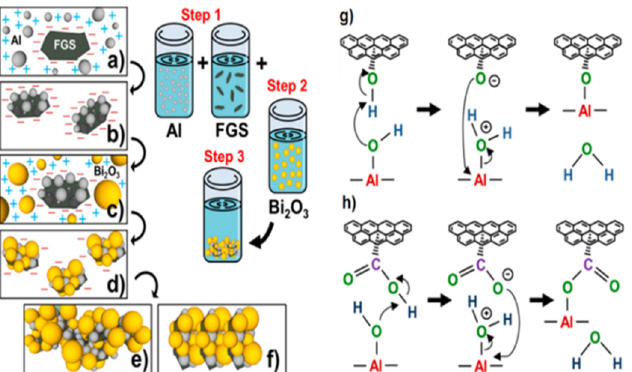
Figure 6. Schematic of the self-assembly process: ( a ) electrostatic attraction of Al to graphene, ( b ) covalent bonding of graphene/Al existing as a stable graphene/Al dispersion, ( c ) electrostatic attraction of Bi 2 O 3 to graphene/Al nanostructures, ( d ) noncovalent assembly of Bi 2 O 3 on graphene/Al; instability of graphene/Al/Bi 2 O 3 dispersion continues the self-assembly process to form ultradense macrostructures, ( e ) The relative ratio of GO to Al and Bi 2 O 3 drives the iterative self-assembly process of the macrostructures into layer by layer, ( f ) The relative ratio of GO to Al and Bi 2 O 3 drives the iterative self-assembly process of the macrostructures into random orientations, ( g ) Chemical interactions between hydroxyl groups of GO and surface hydroxyl groups of Al nanoparticles leading to C–O–Al covalent bond, and ( h ) carboxylic groups of GO and hydroxyl groups of Al nanoparticles leading to O=C–O–Al covalent bond. Reprinted with permission from ref. [25]. Copyright 2014 American Chemical